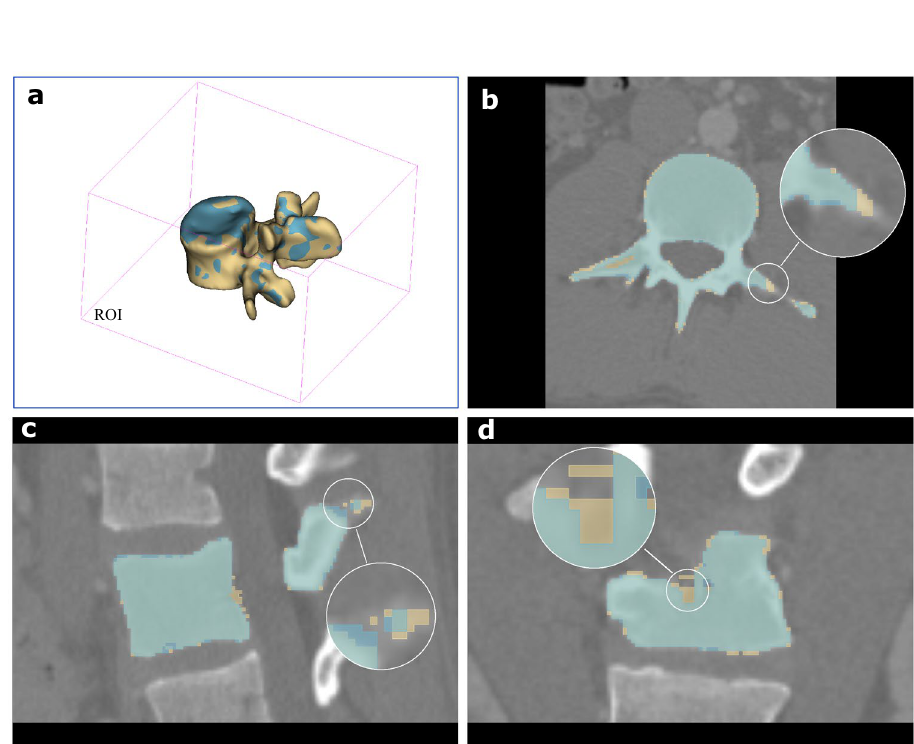
Figure 8. Visual demonstration of the predicted (blue) and the ground-truth (yellow) of case15/L3. ( a ) 3D model. ( b ) Transversal plane. ( c ) Sagittal plane. ( d ) Coronal